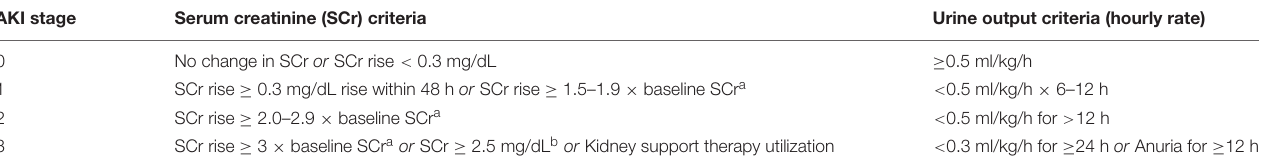
TABLE 1 | Neonatal acute kidney injury diagnostic criteria. AKI stage Serum creatinine (SCr)